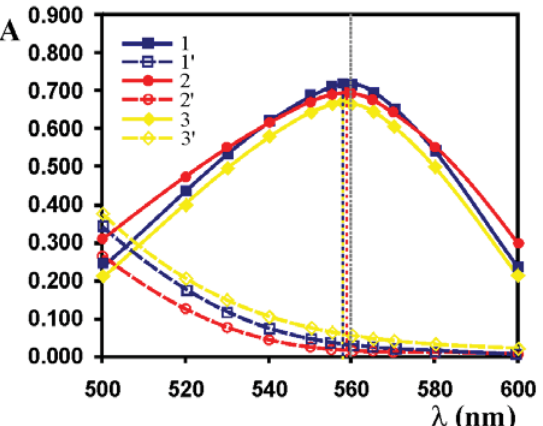
Figure 1. Absorption spectra in chloroform. C C =C =2×10 -4 mol L -1 , l=1.0 cm. 1- V(IV)-PAR-NTC PAR DTC (pH=4.7); 1’- PAR-NTC (pH=4.7); 2- V(IV)-PAR-NBT (pH=3.9); 2’- PAR-NBT (pH=3.9); 3- V(IV)-PAR-BTC (pH=4.8); 3’- PAR-BTC (pH=4.8).